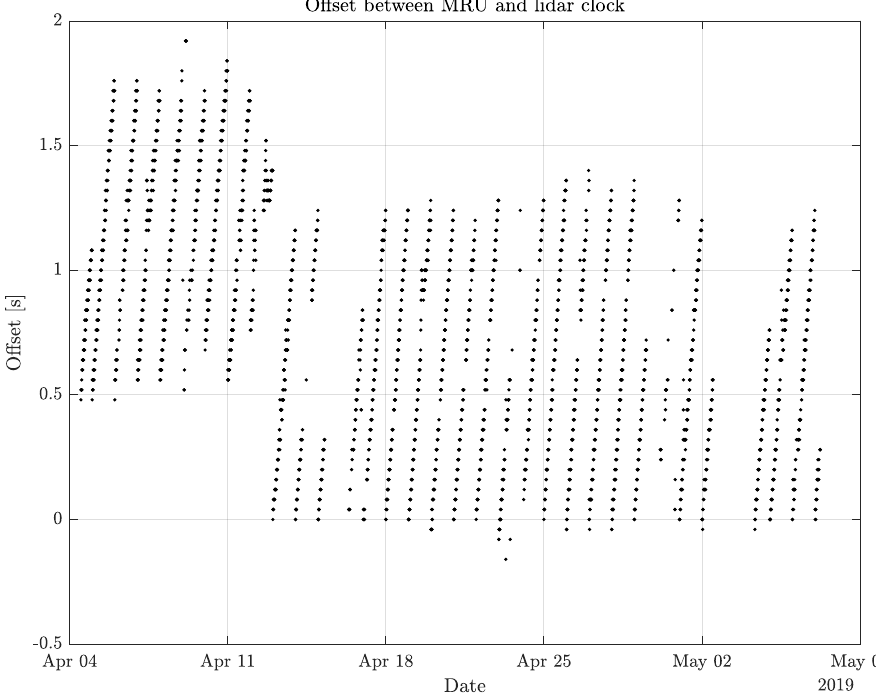
Figure 5. Timing offset at which the sweet spot from Figure 4 is found for all available ten-minute